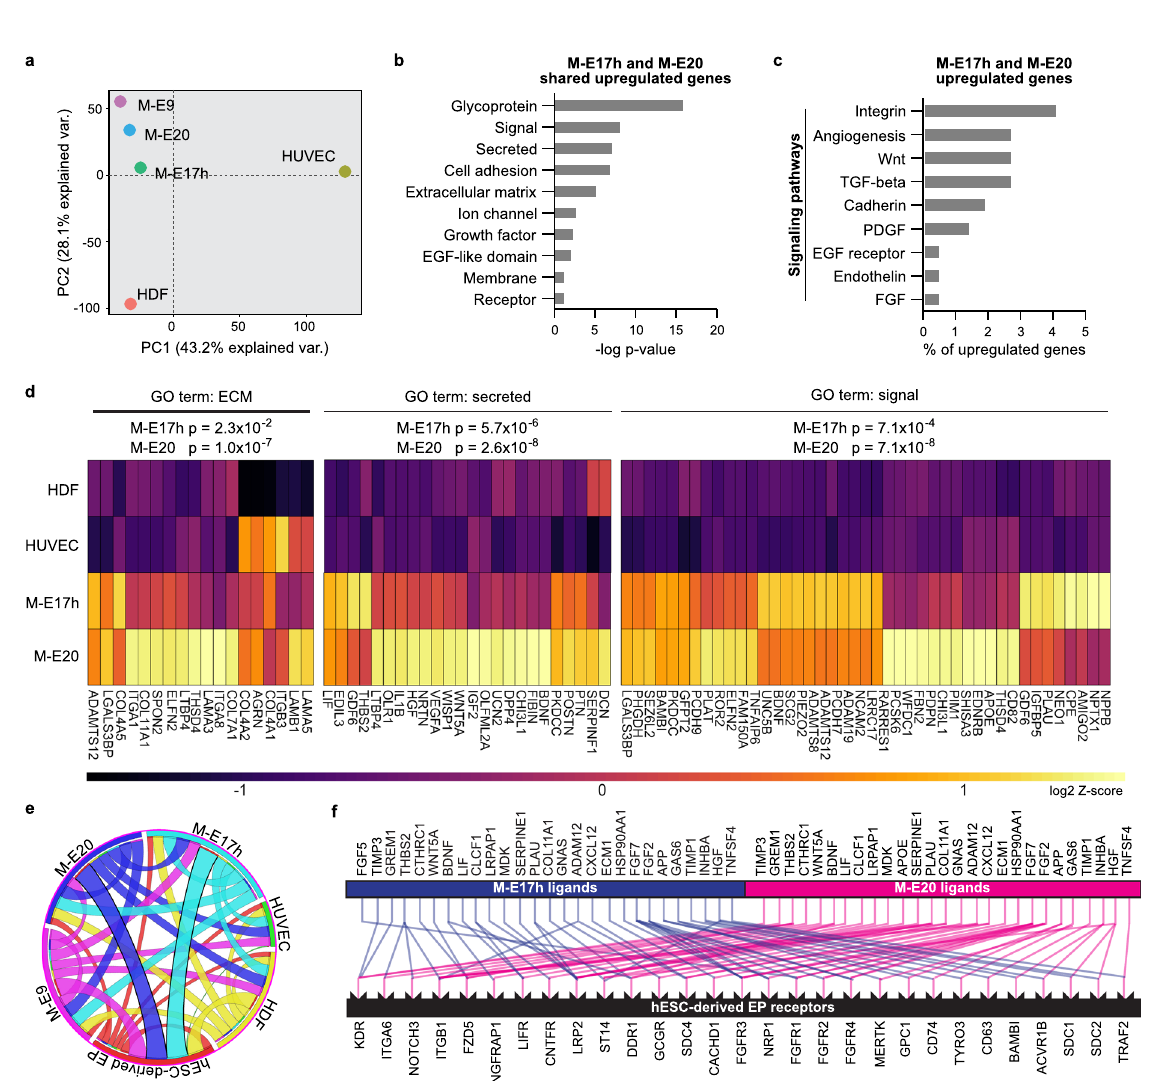
Fig. 2 ECM or conditioned media from M-E cells increase C-peptide positive cells in pancreatic progenitors. a Overview of approach to determine the contribution of the extracellular matrix (ECM) or conditioned media (CM) from M-E cells to PP differentiation into β -cells. b Images of PPs cultured for 14 days on the ECM derived from M-E or MEF cells and probed with anti-C-peptide antibody. DAPI marks nuclei. Scale bar = 100 µ m. N = 5 independent experiments. c Scatter plots of C-peptide + cell quanti fi cation after 14-day culture of PPs with ECM as a fold change over basic media (W/O). Mean ± 95% CI, and signi fi cant p values (Dunnett ’ s multiple comparison test) vs. W/O are shown. N = 5 independent experiments. d Images of PPs cultured for 14 days in conditioned media (CM) derived from M-E or MEF cells and probed with anti-C-peptide antibody. DAPI marks nuclei. Scale bar = 100 µ m. N = 5 independent experiments. e Scatter plots of C-peptide + cells quanti fi cation after 14-day culture of PPs with conditioned media (CM) as a fold change over basic media (W/O). Mean ± 95% CI, and signi fi cant p values (Dunnett ’ s multiple comparison test) vs. W/O are shown. M-E20-HI is a heat-inactivated CM from M-E20 cells. N = 5 or 3 (HI control) independent experiments. f Approach to determine if EP coculture with M-E17 or M-E20 primary M-E cells potentiates C-peptide + cells. g Quanti fi cation of IF data showing C-peptide + cells after either PP or EP coculture with M-E cells for 7 or 3 days, respectively. Mean± 95% CI fold change normalized to non-coculture control (W/O) is shown. N = 6 independent experiments. h GSIS analysis at day 3 of EP coculture with M-E cells. Scatter plot representing ELISA measurements of human C-peptide after stimulating with 2.8 mM and 16.7 mM glucose. N = 4 independent experiments. Results were normalized to cell number and total protein content. Mean± 95% CI, and signi fi cant p values (Dunnett ’ s multiple comparison test) vs. W/O control are shown. Additionally, stimulation index (SI) values, counted as in Fig. 1h, are shown for the effective M-E17 and M-E20 conditions.